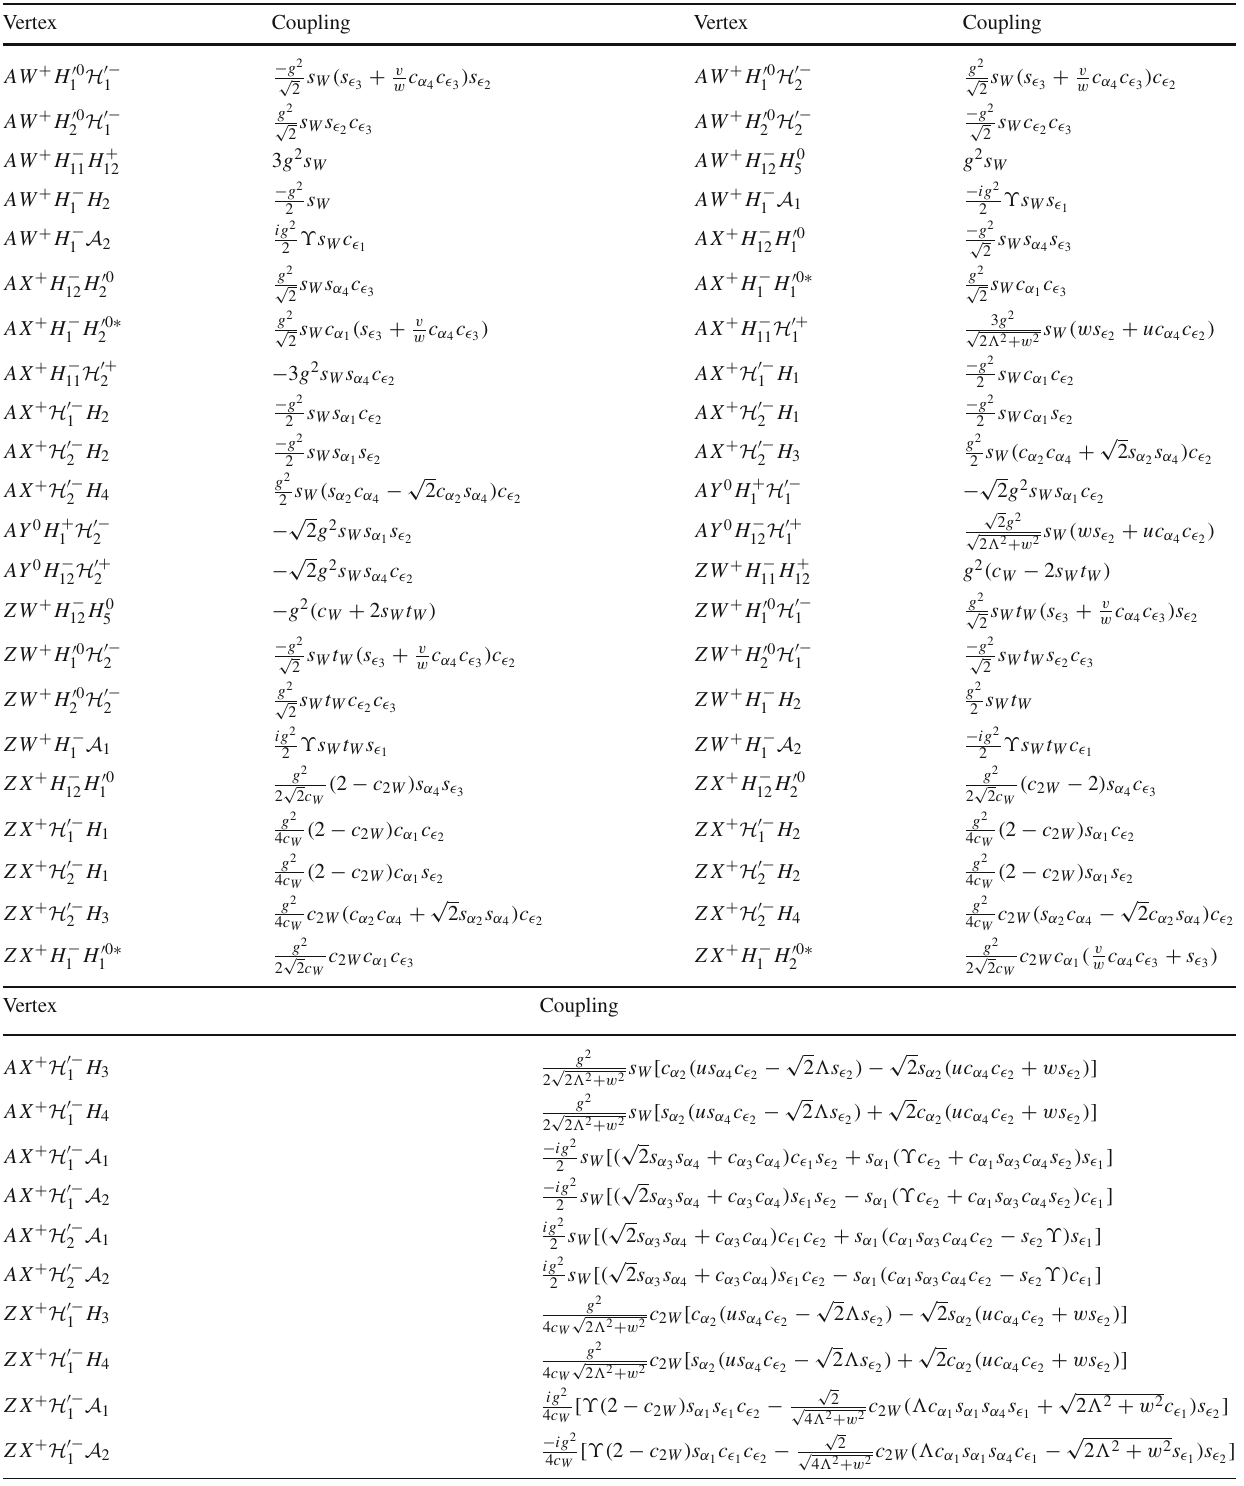
Table 6 The interactions of a neutral and a charged gauge boson with two scalars (Table